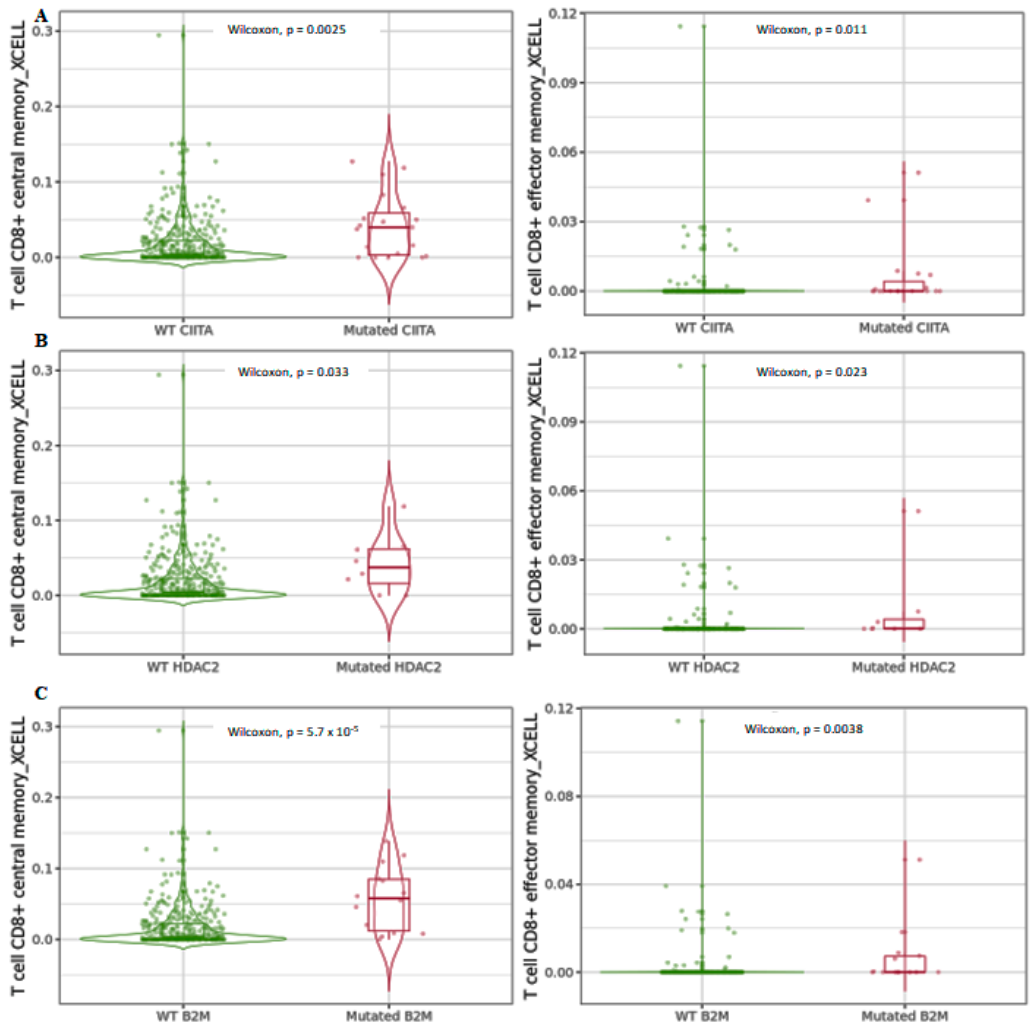
Figure 8. Differential central and effector memory CD8 + T-cell infiltration levels using xCell in mutated ( A ) CIITA , ( B ) HDAC2 , and ( C ) B2M compared to wild-type forms in COAD tumors. Data are shown in Log2 scale (fold change): higher level in mutants = p < 0.05, Log2FC > 0; lower level in mutants = p < 0.05, Log2FC < 0; not significant = p > 0.05.